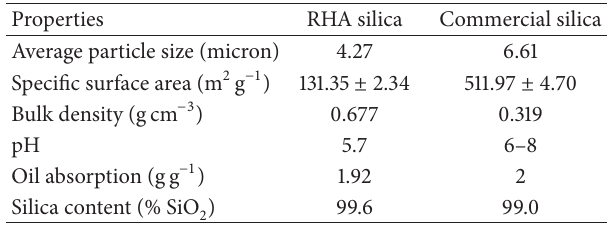
Table 5: Properties of RHA silica and commercial silica [44]. Properties RHA silica Commercial